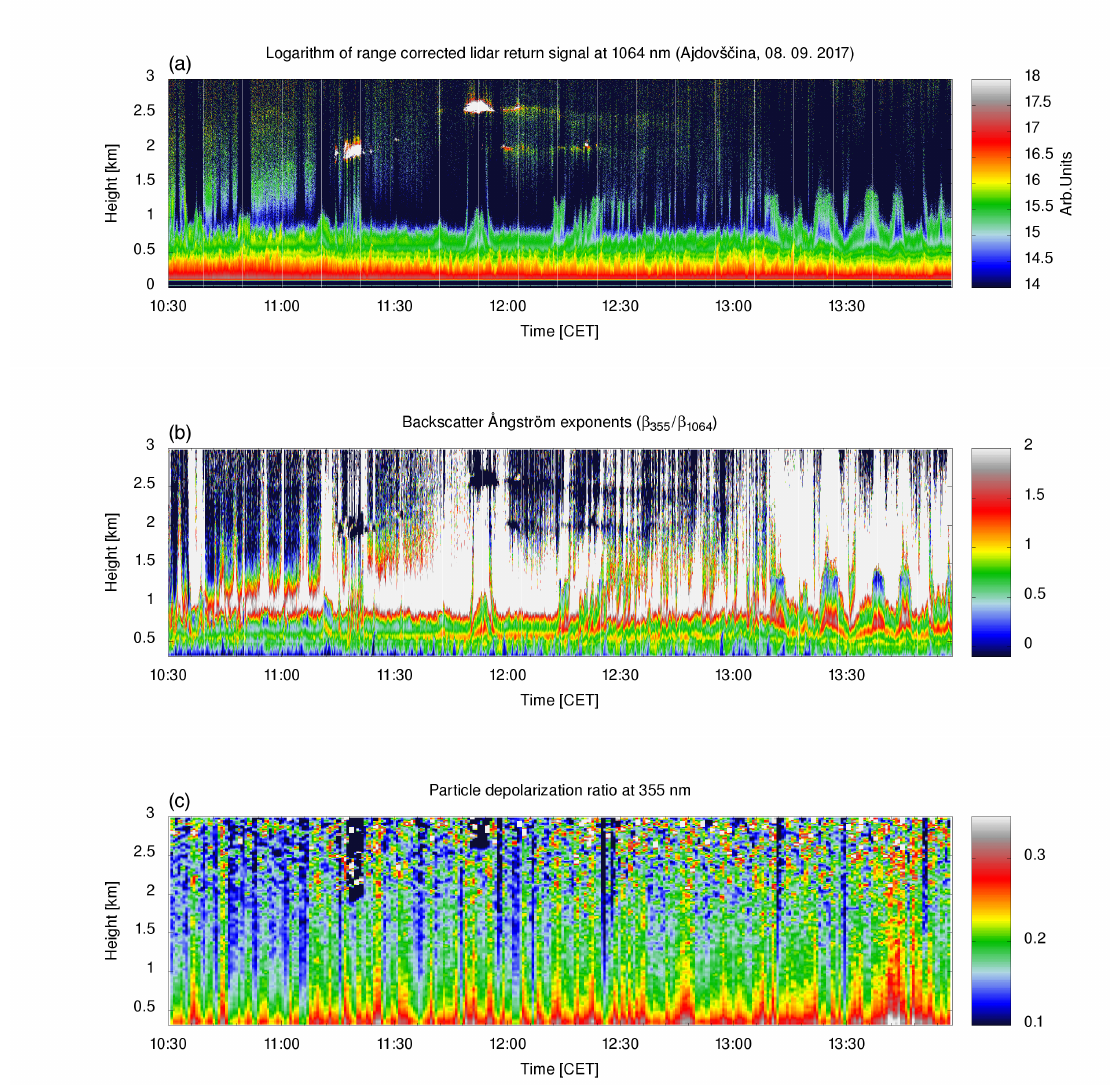
Figure 2. Temporal variation of aerosol distribution over the Vipava valley during a Bora episode on 8 September 2017 from 10:30 to 14:00 CET. ( a ) Logarithm of range square corrected LiDAR return at 1064nm (arbitrary units). ( b ) BAE based on the combination 355nm and 1064nm backscatter coefficients. ( c ) PDR. For all three figures the data was re-sampled to 18.75m range resolution. The values are shown for heights within the complete LiDAR overlap range. The heights are relative to